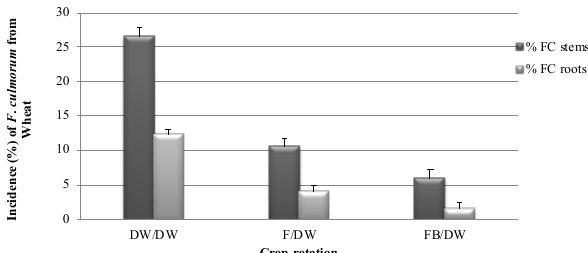
Figure 4. Mean incidence of Fusarium culmorum infection on wheat stem bases and roots as affected by different previous crops (DW = durum wheat; F = fenugreek; FB = faba bean), at the Bou Salem, Tunisia, field trial in the 2013/14 and 2014/15 cropping sea- sons. Error bars are 2 × standard deviations.